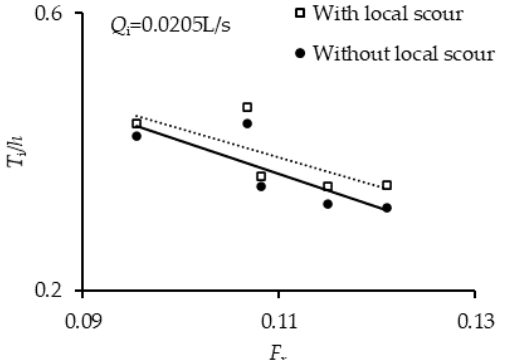
Figure 11. Relationship between Ti / h and F r with and without a local scour.